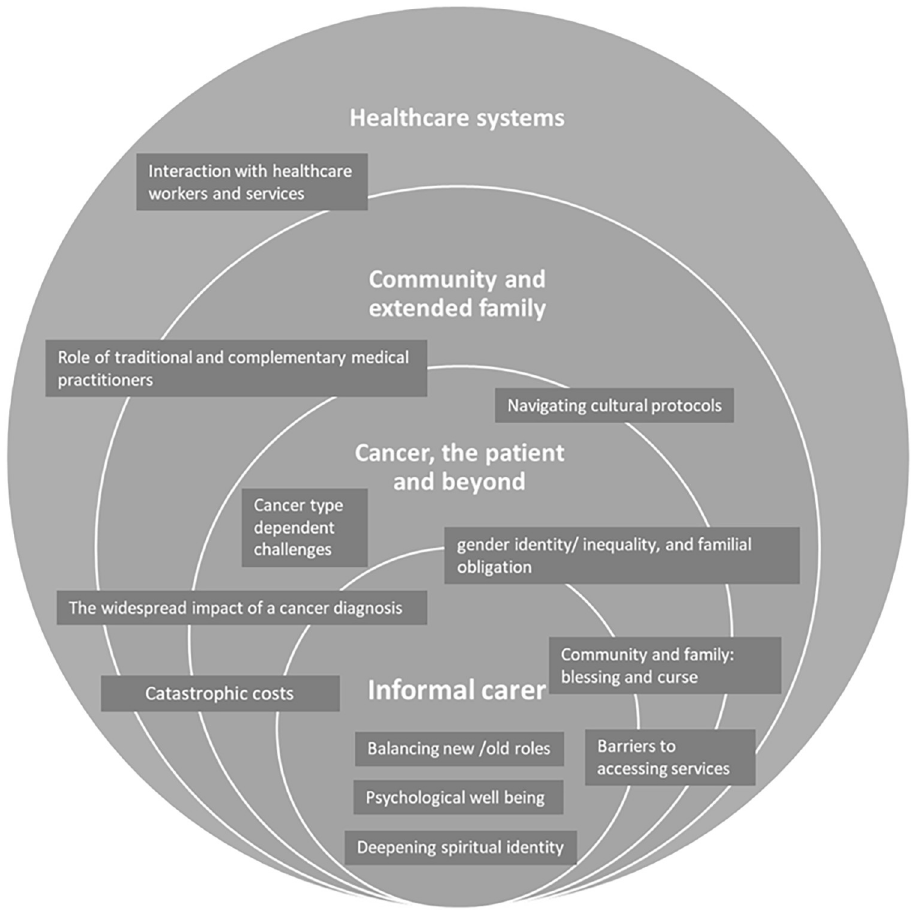
Fig 2. A social-ecological framework of the components of the informal carer’s experience (adapted from Bronfenbrenner’s social ecological model [21, 22]).